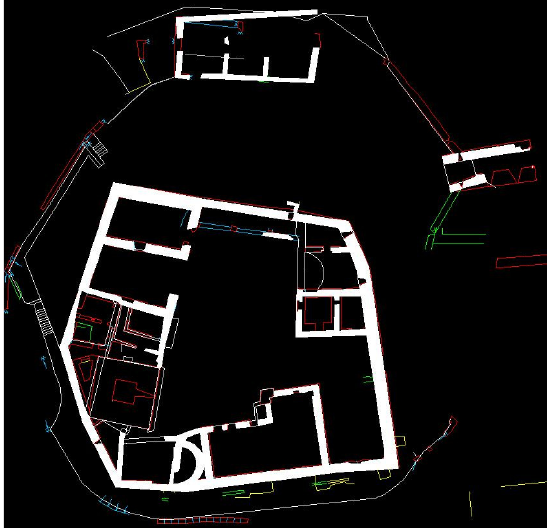
Figure 6: The new map (white and thick walls) of the heritage derived from the range-based 3D model, superimposed onto the old cadastral map.